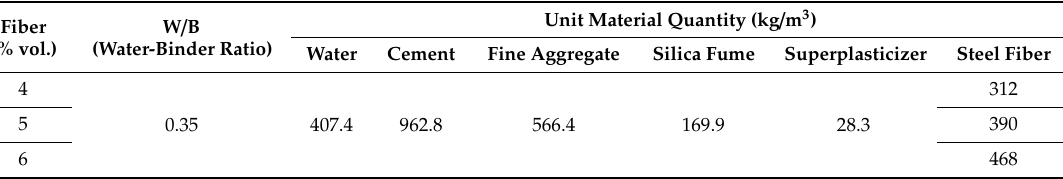
Table 4. Mix proportions of slurry-infiltrated fiber-reinforced cementitious composites (SIFRCCs) [2,3,12,20]. Fiber (%